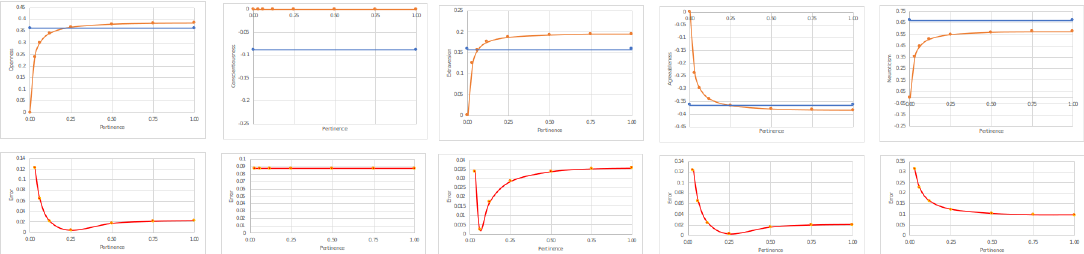
Figure 10. Error graphics from Anger input emotion—OCEANS’s factors.